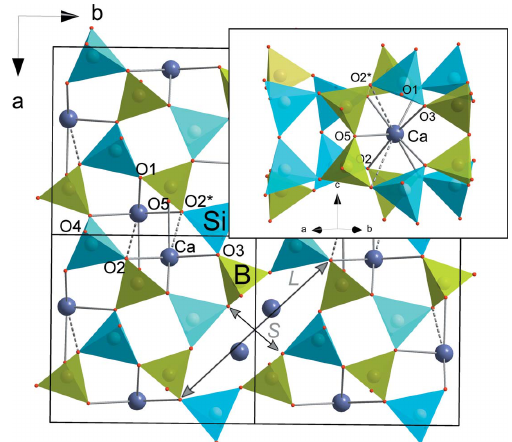
Figure 1 The crystal structure of danburite under ambient conditions, viewed along the c axis. Green and blue tetrahedra represent BO 4 and SiO 4 , respectively. The Ca atoms are shown in dark blue. The inset shows the coordination of a Ca atom, where the dotted lines correspond to bond lengths exceeding 3 A˚